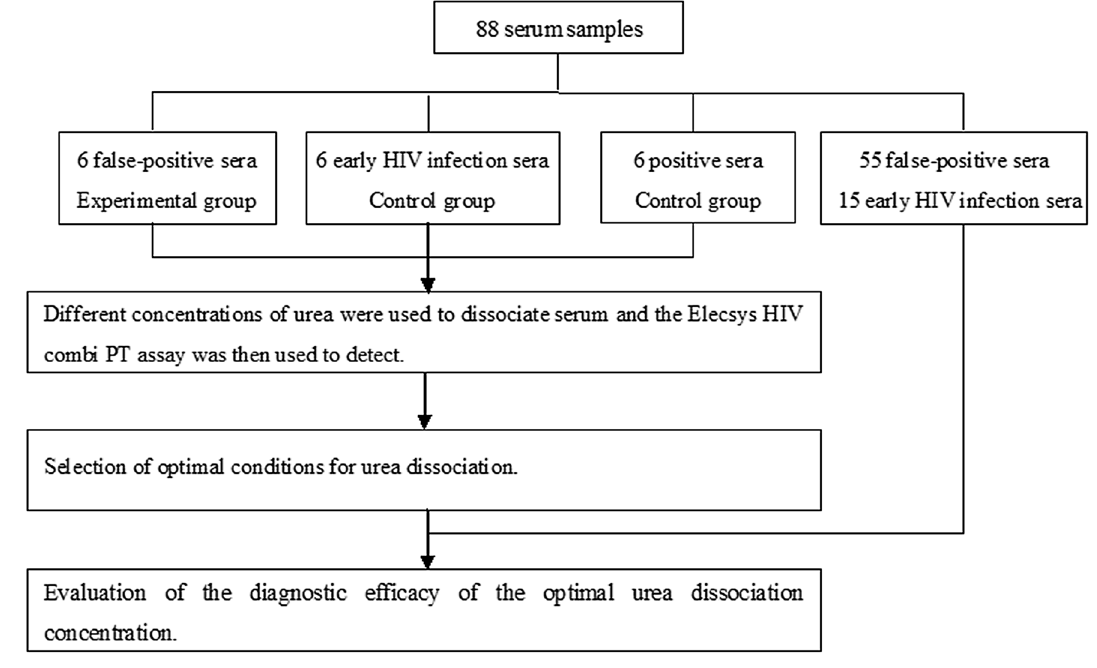
Figure 6. Flowchart depicting the study